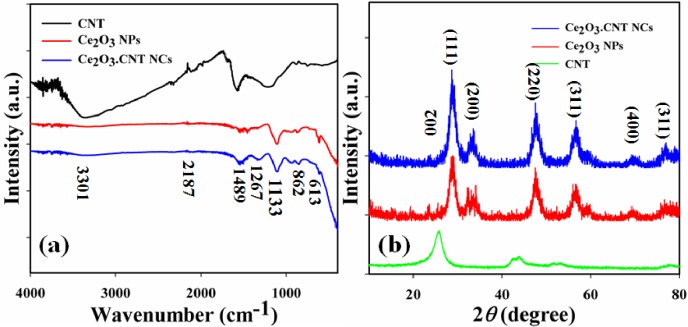
(a) FTIR spectra and (b) XRD pattern of the CNT, Ce2O3 NPs and Ce2O3.CNT NCs.